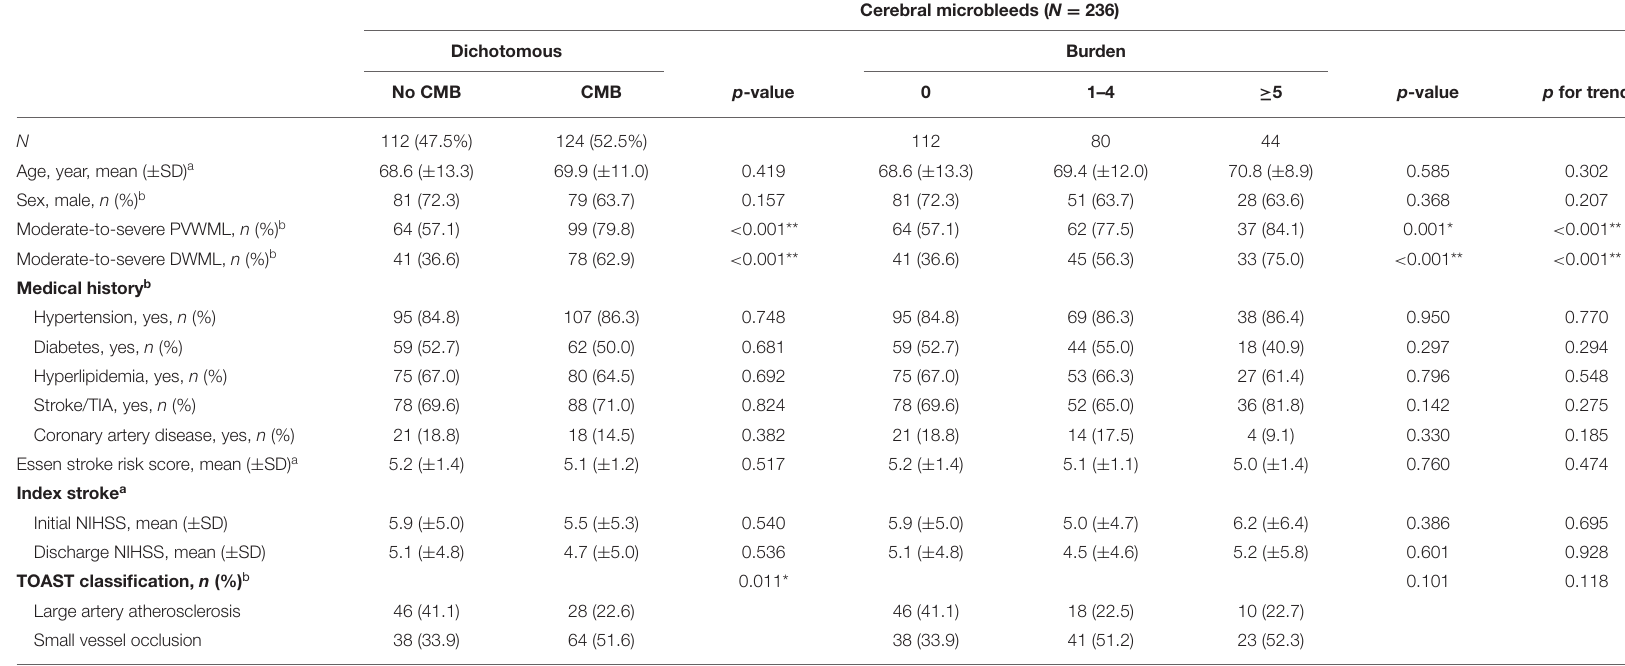
TABLE 4 | Relationship between cerebral microbleeds and characteristics of stroke patients with aspirin treatment failure. Cerebral microbleeds ( N = 236) Dichotomous